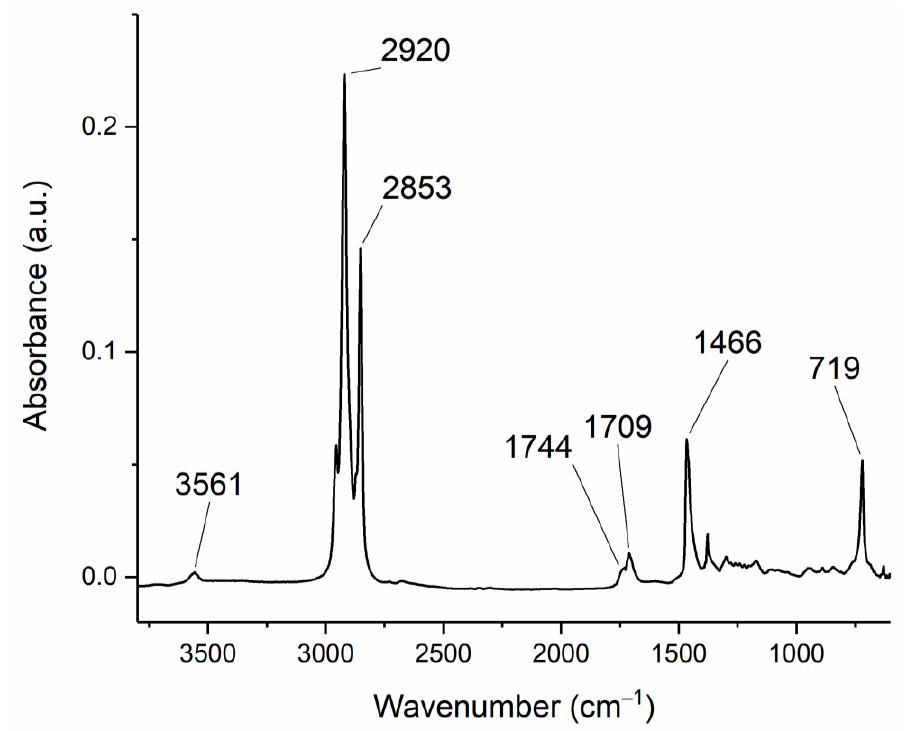
Figure 15. FT-IR spectrum for deoxygenated canola FAME product.